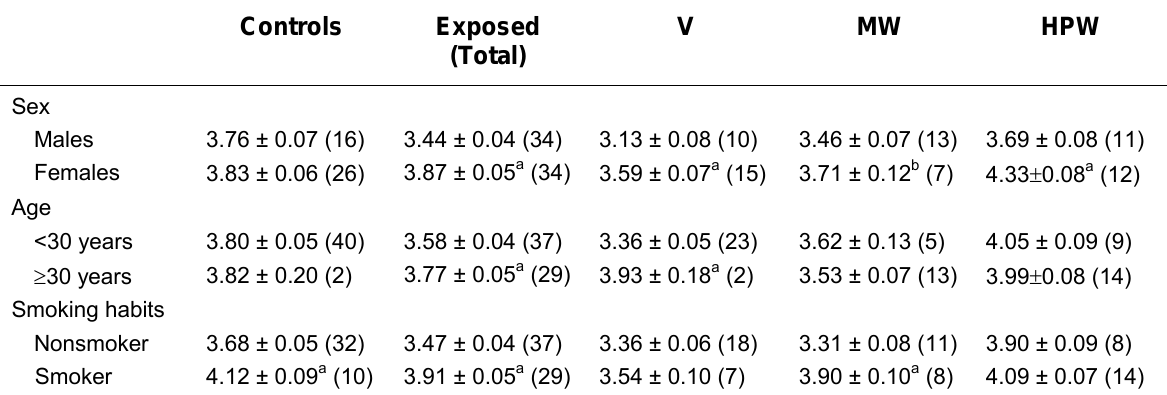
Influence of Sex, Age, and Smoking Habits on SCE Frequency (mean ± SE)